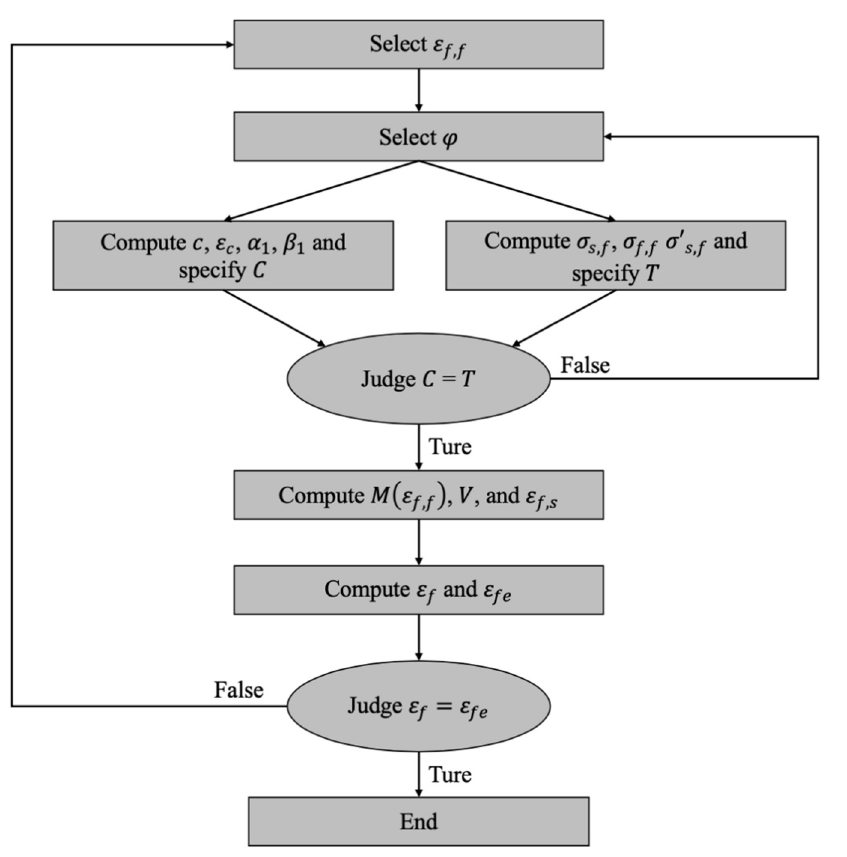
Figure 19. Analysis flowchart to assess the carrying capacity of strengthened RC beams.